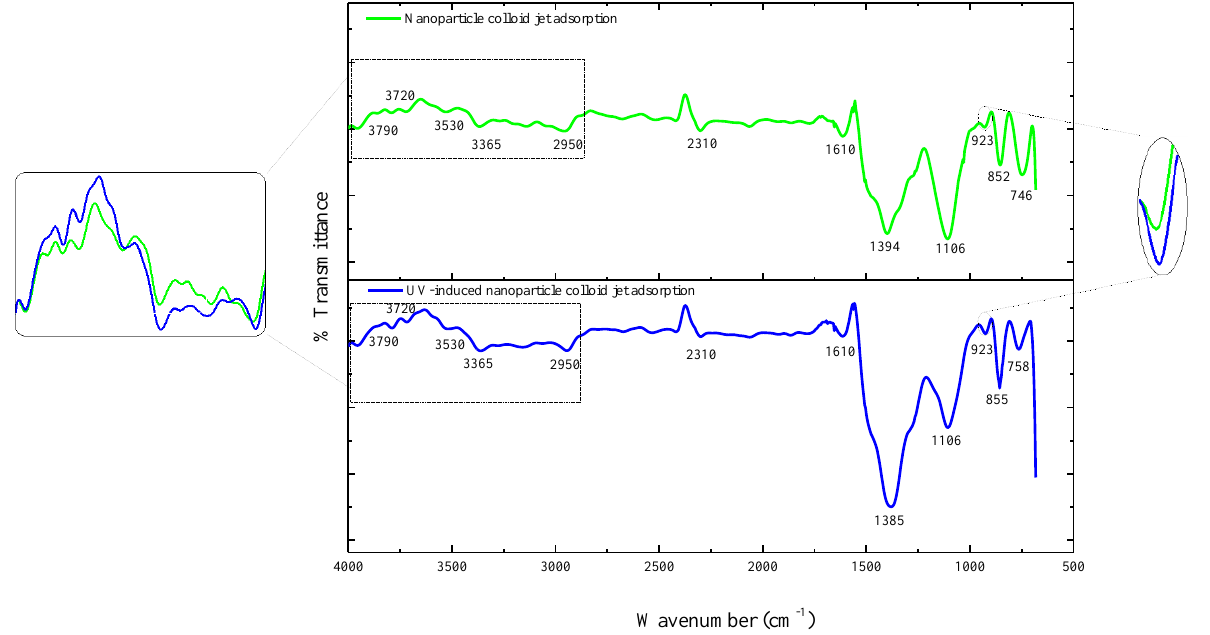
Figure 9. Differential display of the infrared spectrogram of the Si workpiece samples. The bands at 746–758 cm − 1 in the above two samples can be attributed to the Ti-O band, indicating that there are TiO 2 nanoparticles adsorbed on both Si workpiece samples. The bands at 852–855, 1106, and 1385–1394 cm − 1 are attributed to the stretching vibration of the Si-O band. The bands at 3790, 3720, and 3365–2950 cm − 1 are attributed to the stretching vibration of the OH band. The band at 1610 cm − 1 belongs to the bending vibration